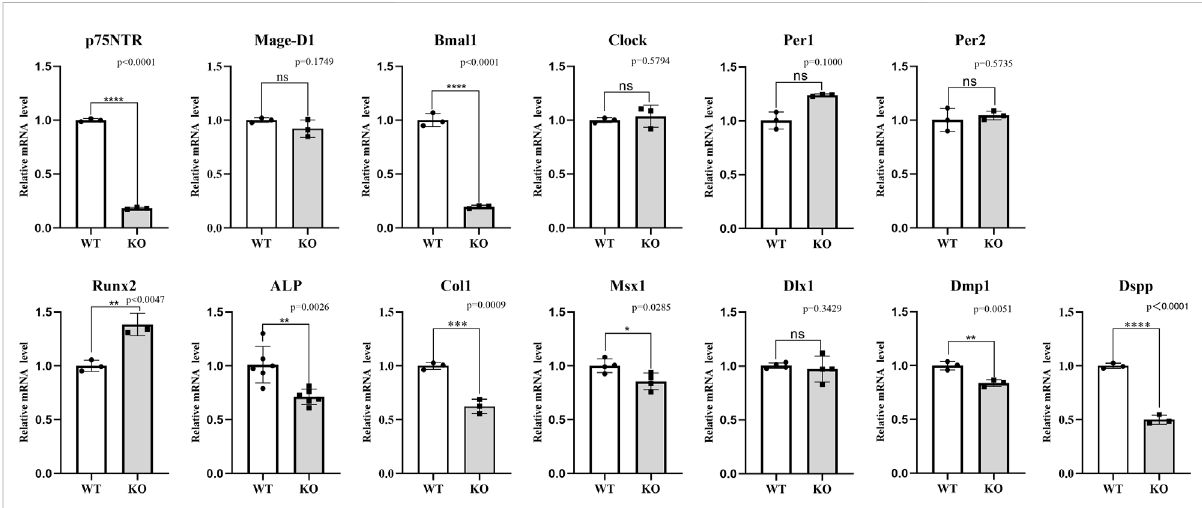
FIGURE 6 The in vivo assays for the effect of p75NTR knockout on the mRNA expression in dental germs at PN7d. As expected, p75NTR mRNA in the knockout mice was signi fi cantly lower than in THE wild-type mice ( p < 0.05). Mage-D1 , Bmal1 , ALP , Col1 , Msx1 , Dmp1 , and Dspp showed the same change in the p75NTR knockout mice, indicating a positive relationship with p75NTR . In contrast, Runx2 showed the reverse change, presenting a negativerelationshipwith p75NTR . Clock , Per1 , Per2 ,and Dlx1 showednosigni fi cantdifferencebetween p75NTR knockoutandwild-typemice ( p > 0.05). All experiments were repeated at least three times independently. Data are expressed as mean ± S.D. L. D. Condition group, n = 6; D. D. Condition group, n =